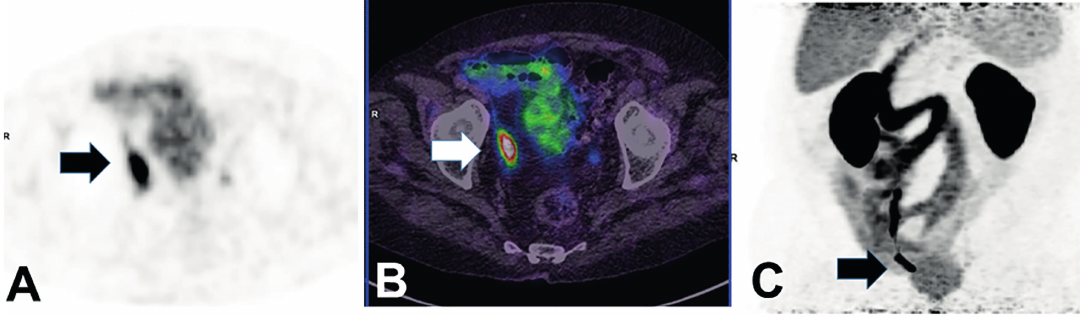
Figure 4 - Deferent duct